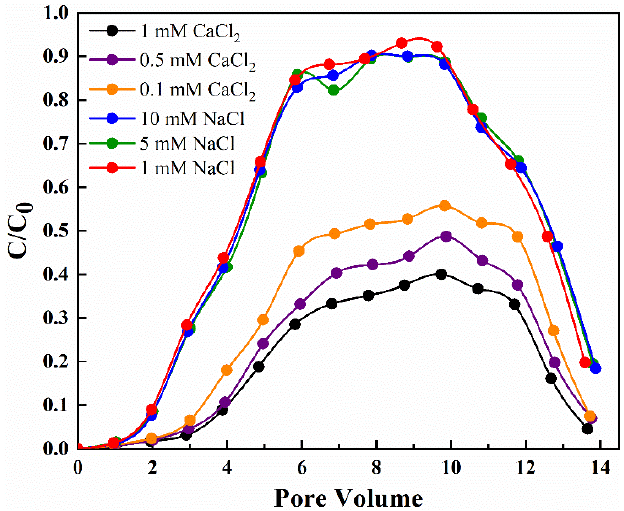
Figure 3. The influence of the ionic strength (IS) on the vertical migration of PHE in soil.